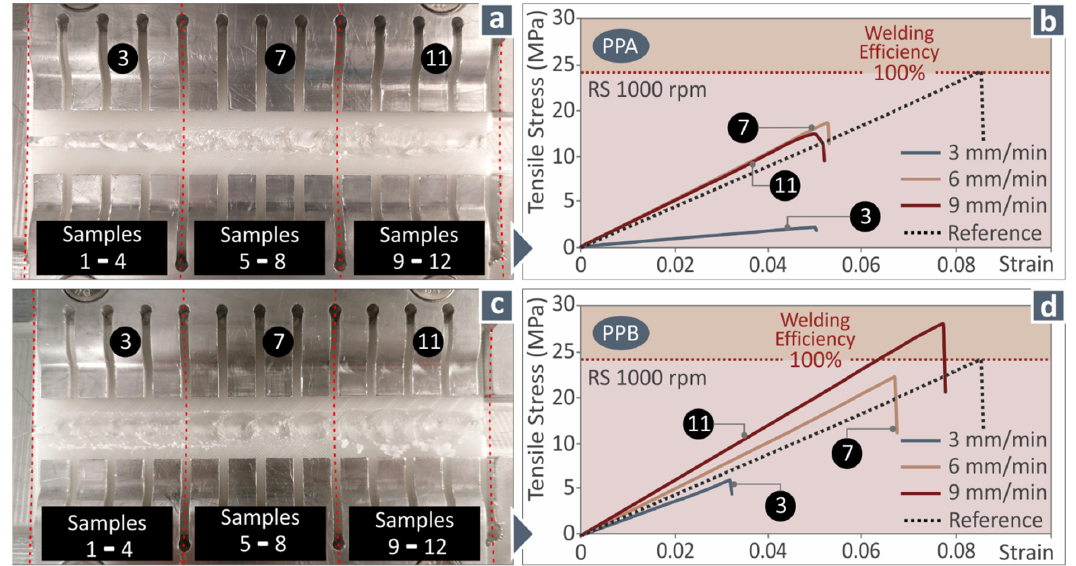
Figure 4. ( a ) PPA welding tool’s weld seam; ( b ) stress–strain graphs from the tensile tests for the different TS values (RS 1000 rpm, PPA); ( c ) PPB welding tool’s weld seam; ( d ) stress–strain graphs from the tensile tests for the different TS values (RS 1000 rpm, PPB).